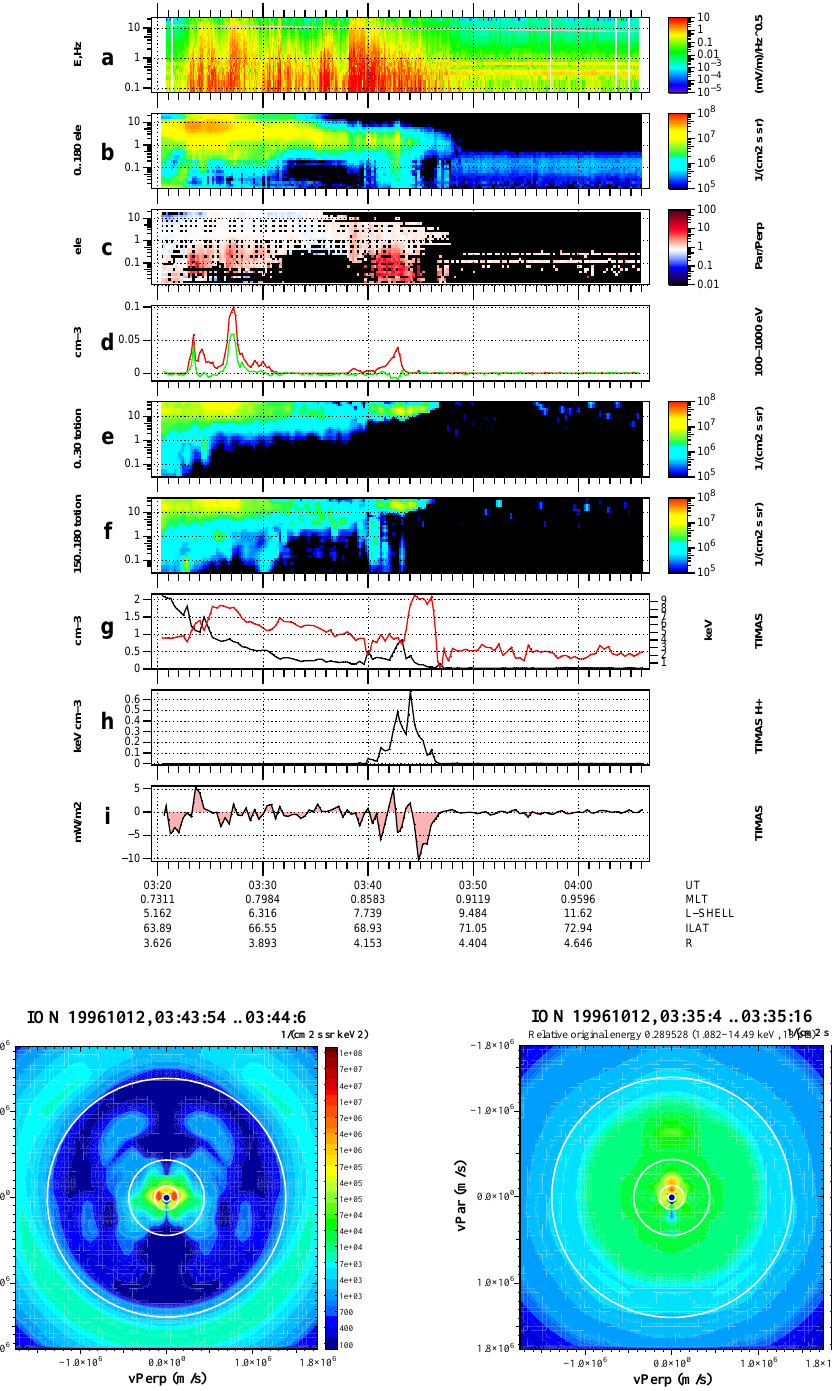
Fig. 9. Polar data for 12 October 1996, 03:20–04:08UT. Example of an event containing a full (i.e. up/down symmetric) shell distribution. Upper subfigure: (a) EFI electric wave amplitude spectrogram, (b) electron differential energy flux spectrogram from HYDRA including all pitch angles (c) ratio of parallel to perpendicular electron distribution function from HYDRA, red regions signifying parallel electron energisation, (d) parallel minus perpendicular electron distribution function integrated between 0.1 and 1keV, i.e. the anisotropic density (red) and up minus down parallel component, positive meaning upgoing electrons (green), (e) total ion distribution function from TIMAS for 0–30 ◦ pitch angle, i.e. downgoing, (f) same for antiparallel (upgoing) ions, i.e. 150–180 ◦ , (g) ion density (black) and temperature (red, scale on the right) computed by integration from TIMAS total ion distribution function, (h) free energy density in TIMAS ion distribution, (i) energy flux estimated from the free energy, positive upward. Left lower subfigure: the full shell distribution in the PSBL, with similar format as in Fig. 2, one-count level 200 times smaller than shell level. Right lower subfigure: distribution function at 03:35UT in the BPS, where a Maxwellian with plateauing tendency is seen, one-count level 30 times smaller than shell